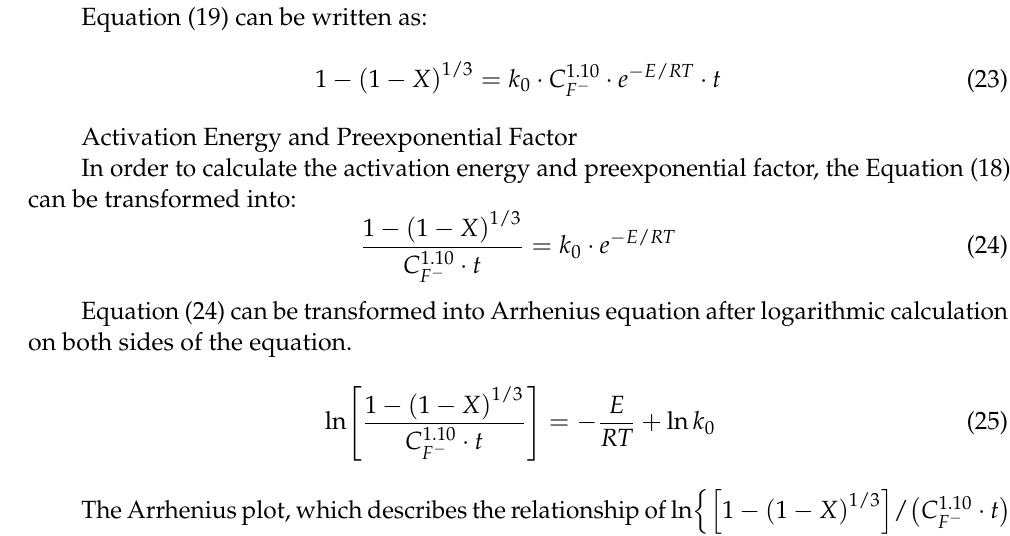
Figure 9. Plot of ln[[1 − (1 − X ) 1/3 ]/ t ] vs. ln C with L / S ratio of 20:1 and rotating speed of 200 r/min. ( a ) 60 °C, ( b ) 70 °C, ( c ) 80 °C, ( d ) 90 °C.